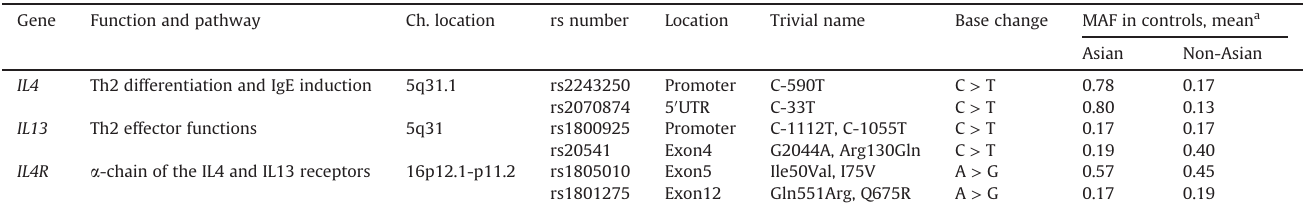
Table 1 Primary information for the six polymorphisms included in the